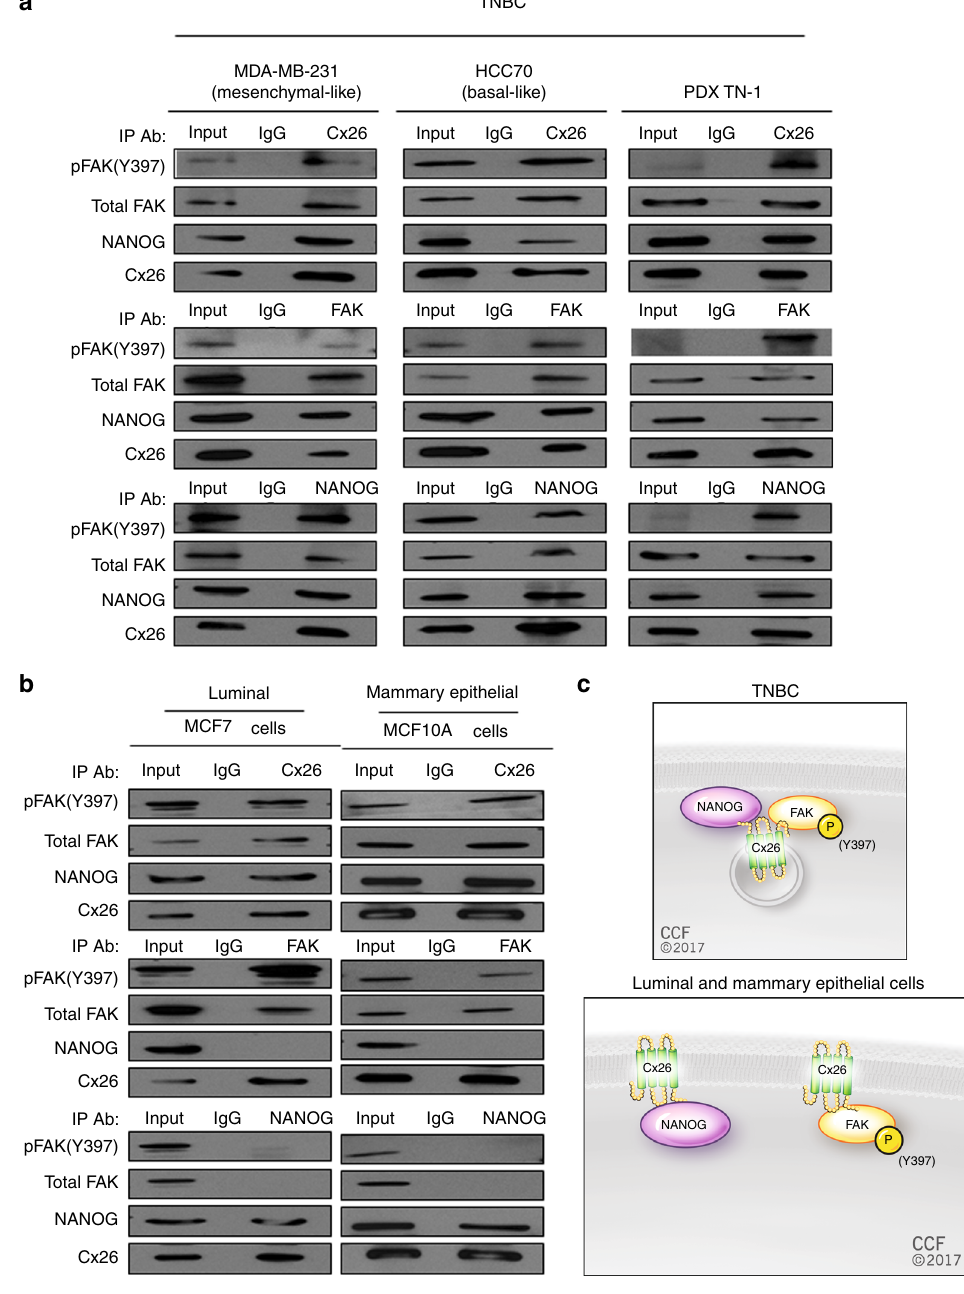
Fig. 4 Cx26 forms a TNBC-speci fi c complex with focal adhesion kinase (FAK) and NANOG. Cell lysates from bulk cell cultures of a mesenchymal-like TNBC (MDA-MB-231), basal-like TNBC (HCC70), TNBC (PDX TN-1), and b non-TNBC (MCF7 and MCF10A) were subjected to immunoprecipitation with anti-Cx26, anti-FAK, and anti-NANOG antibodies. pFAK (Y397), FAK, Cx26, and NANOG proteins in the precipitated complex were detected by western blotting using speci fi c antibodies. Fifteen percent of the lysate used for immunoprecipitation was loaded as the input control. As a negative control, immunoprecipitation with the corresponding non-immune IgG was performed. c Schematic summarizing the interactions detected in TNBC versus mammary epithelial and luminal breast cancer overexpression led to increased Cx26 mRNA in MDA-MB-231 non-CSCs (Fig. 5g) and HCC70 non-CSCs (Supplementary Fig. 9c). In contrast, silencing FAK inhibited expression of Cx26 protein but did not attenuate NANOG protein expression (Supplementary Fig. 10a). As autophosphorylation of FAK was decreased by silencing Cx26 and enhanced by Cx26 over- expression, we tested whether FAK autophosphorylation was required for complex formation. We performed lentiviral transduction of hemagglutinin (HA)-tagged wild-type (WT)